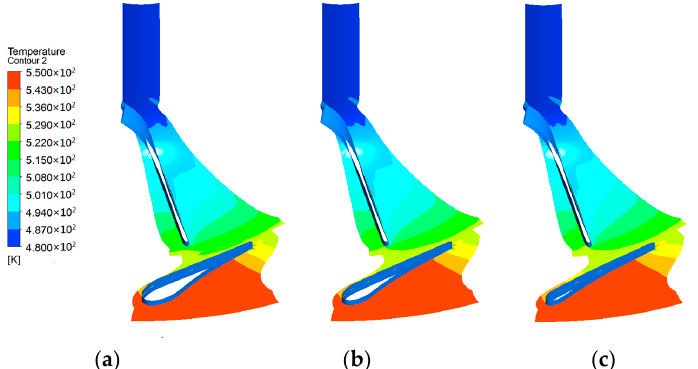
Figure 12. Temperature contours at the mid-span of the impeller and nozzle: ( a ) LED = 10 mm; ( b ) LED = 7 mm; ( c ) LED = 4 mm.